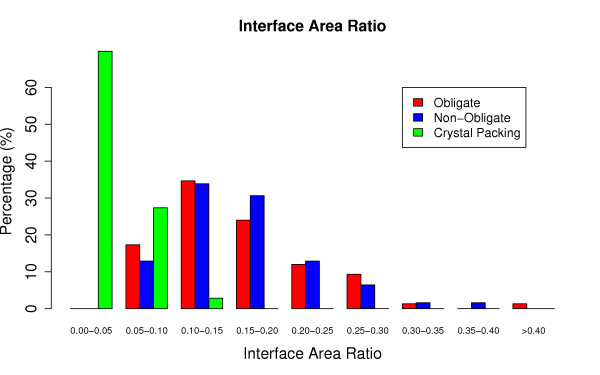
Distribution of interface area ratio for three types of interactions in the BNCP-CS dataset.